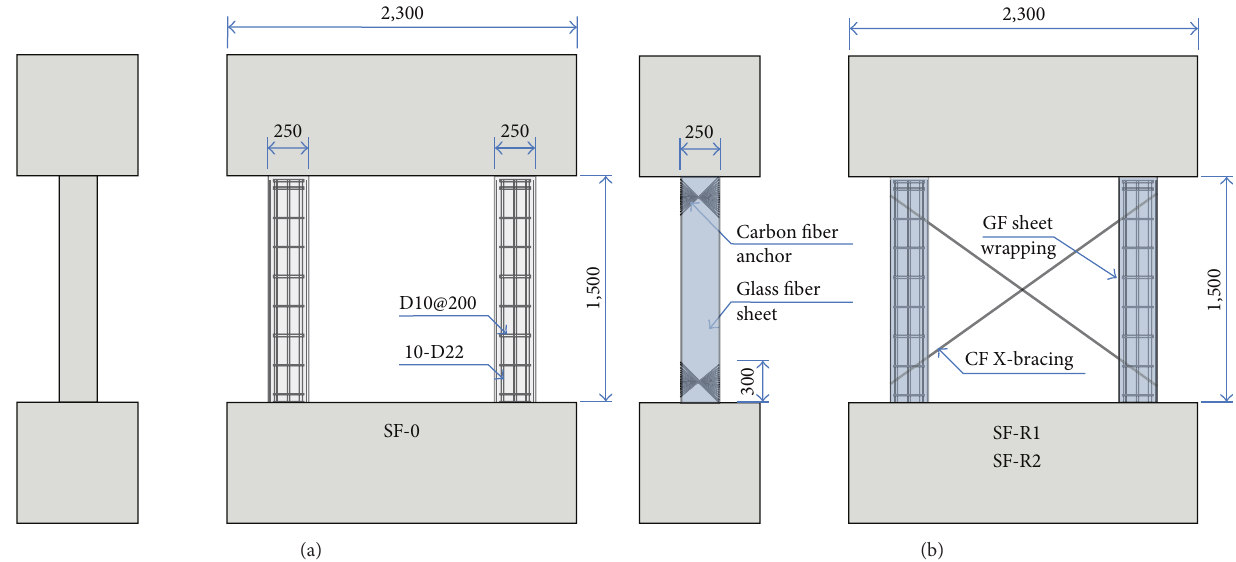
Figure 5: Details of (a) the SF-0 control specimens and (b) the SF-R reinforced specimens. All dimensions are in mm.